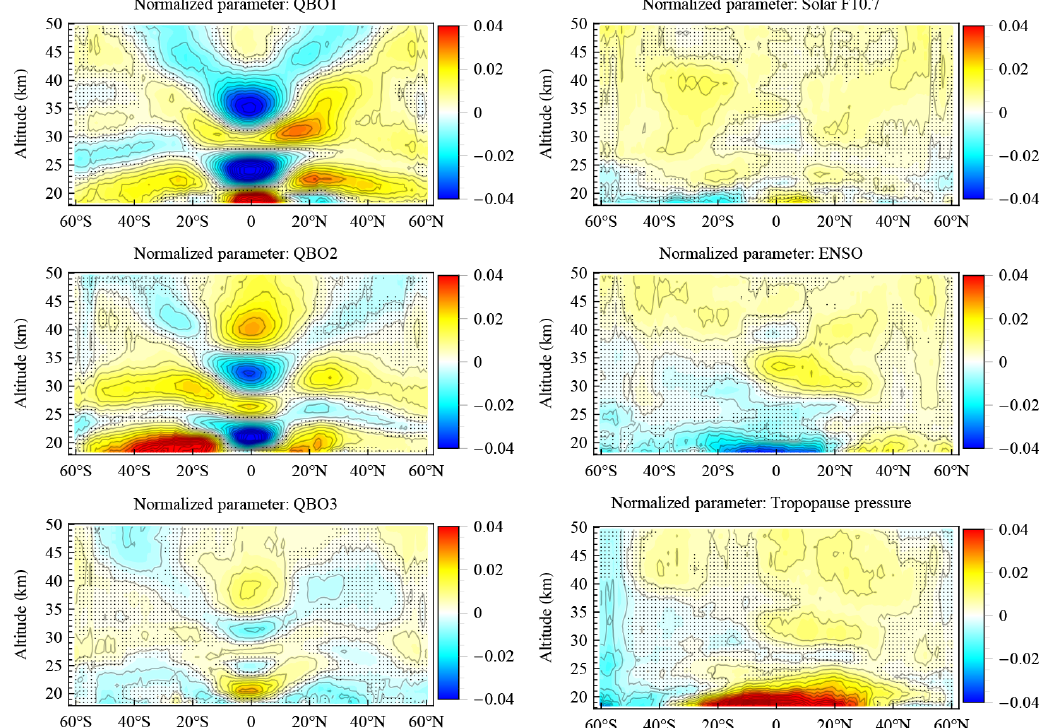
Figure 9. Altitude–latitude cross sections of the normalized fit parameter values for the six predictor basis functions. The units are relative ozone change per one standard deviation of the predictor time series. Regions that are not statistically significant at the 95% level are shown with overlaid grey stippling. In general, throughout the stratosphere the greatest contribution to the relative ozone anomaly comes from the first two principal components of the QBO